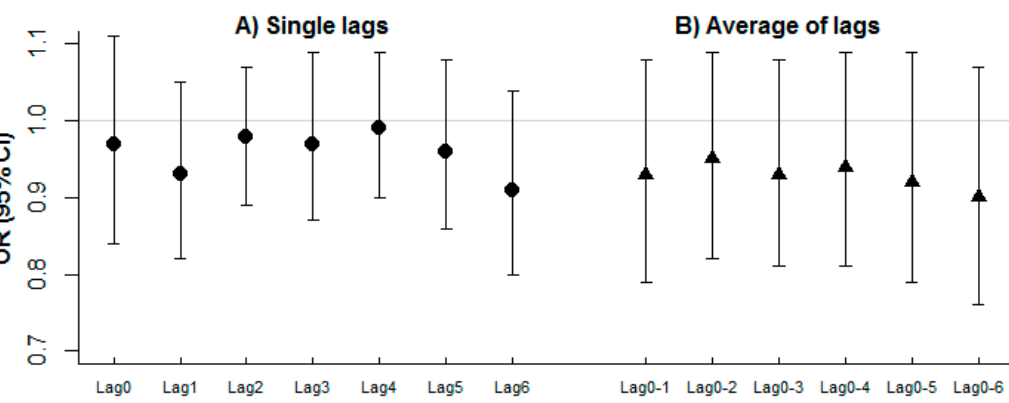
Figure 4. OR (95% CI) for the association of daily RSV admission and average NO concentrations in Sheffield. ( A ) Single lags; ( B ) Average of lags.